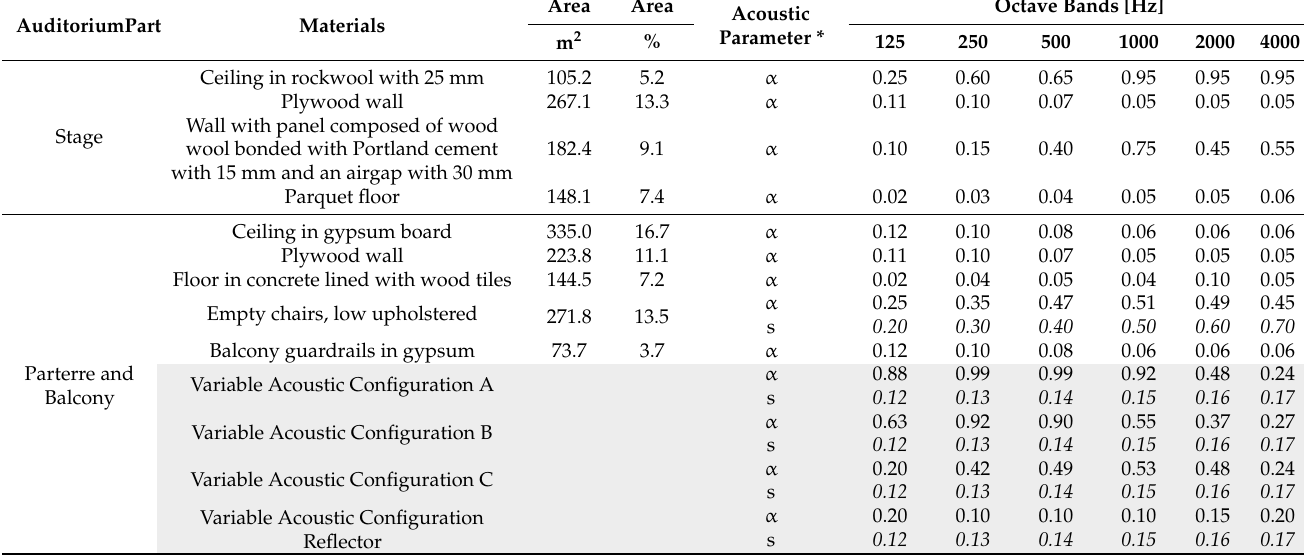
Table 3. Sound absorption ( α ) and scattering (s) coefficients for each lining material, and corresponding surface areas. AuditoriumPart